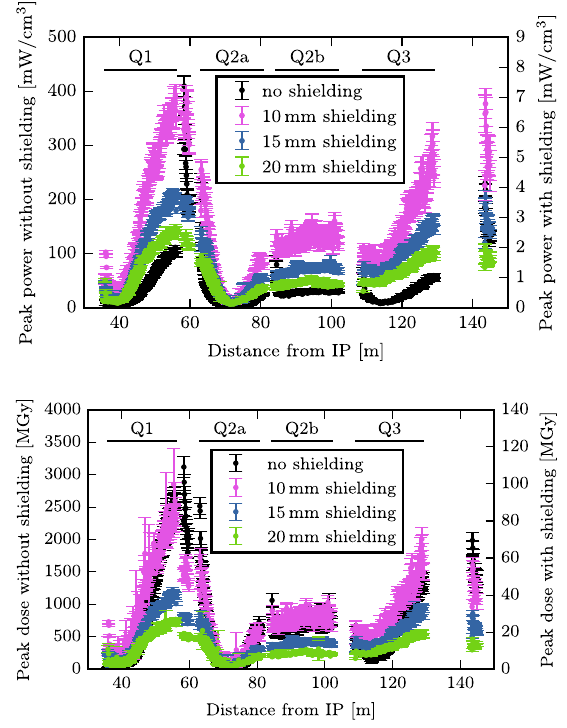
FIG. 5. Peak power densities (top) and peak doses per 3000 fb − 1 (bottom) for the L (cid:2) ¼ 36 m lattice for different shielding thicknesses at 70 μ rad vertical half crossing angle and assuming 100 mm coil aperture.